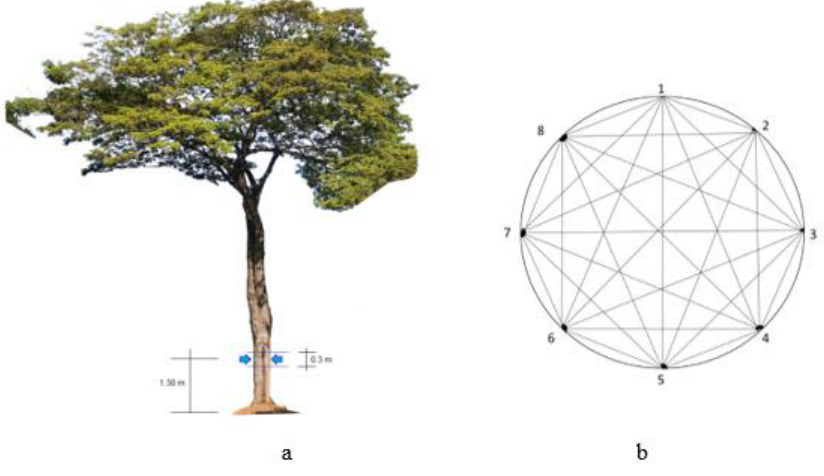
Figure 3. Scheme of the direct test with wave propagation in the radial direction ( a ) and 8-point diffraction mesh adopted for direct radial measurements in the trunk cross-section ( b ).